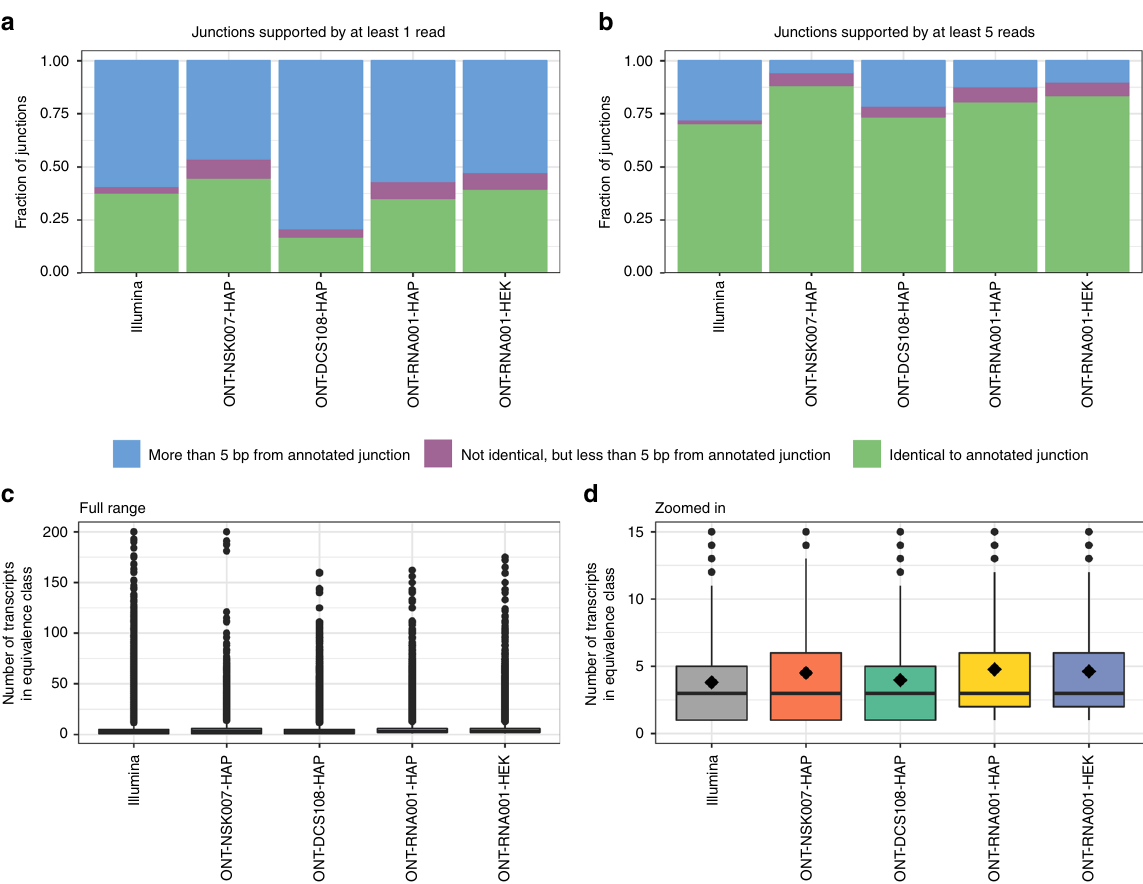
Fig. 5 Investigation of transcript identi fi ability. a , b Annotation status of junctions observed in each ONT and Illumina data set. A junction is considered observed if it is supported by at least 1 ( a ) or 5 ( b ) reads. For each observed junction, the distance to each annotated junction was de fi ned as the absolute difference between their start positions plus the absolute difference between their end positions. This distance was used to fi nd the closest annotated junction. c Distribution of the number of transcripts contained in the Salmon equivalence class that a read is assigned to, across all reads, for each ONT and Illumina data set. The center line represents the median; hinges represent fi rst and third quartiles; whiskers the most extreme values within 1.5 interquartile range from the box. d As ( c ), but zoomed in to the range [0, 15]. The black diamond shape indicates the mean. Source data for panels a , b are provided as a Source Data fi